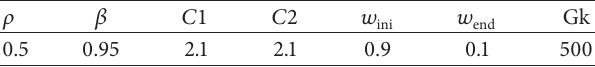
Figure 3: Flow of solving procedure. Table 2: Parameters of algorithm.